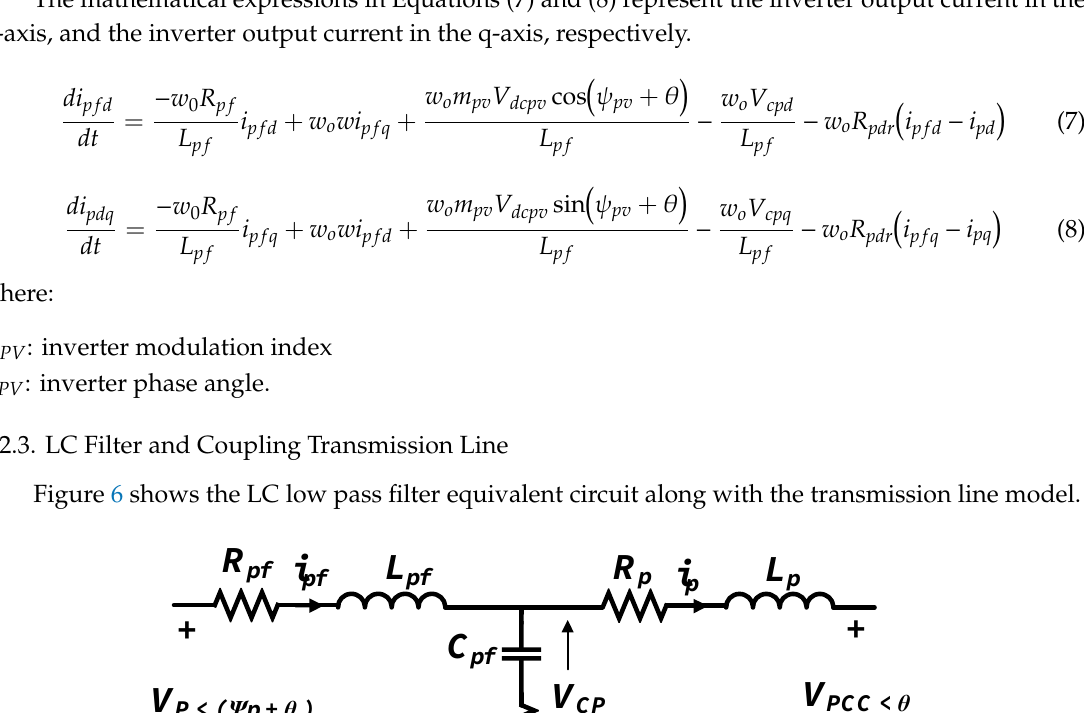
Figure 5. The voltage source inverter (VSI) model.